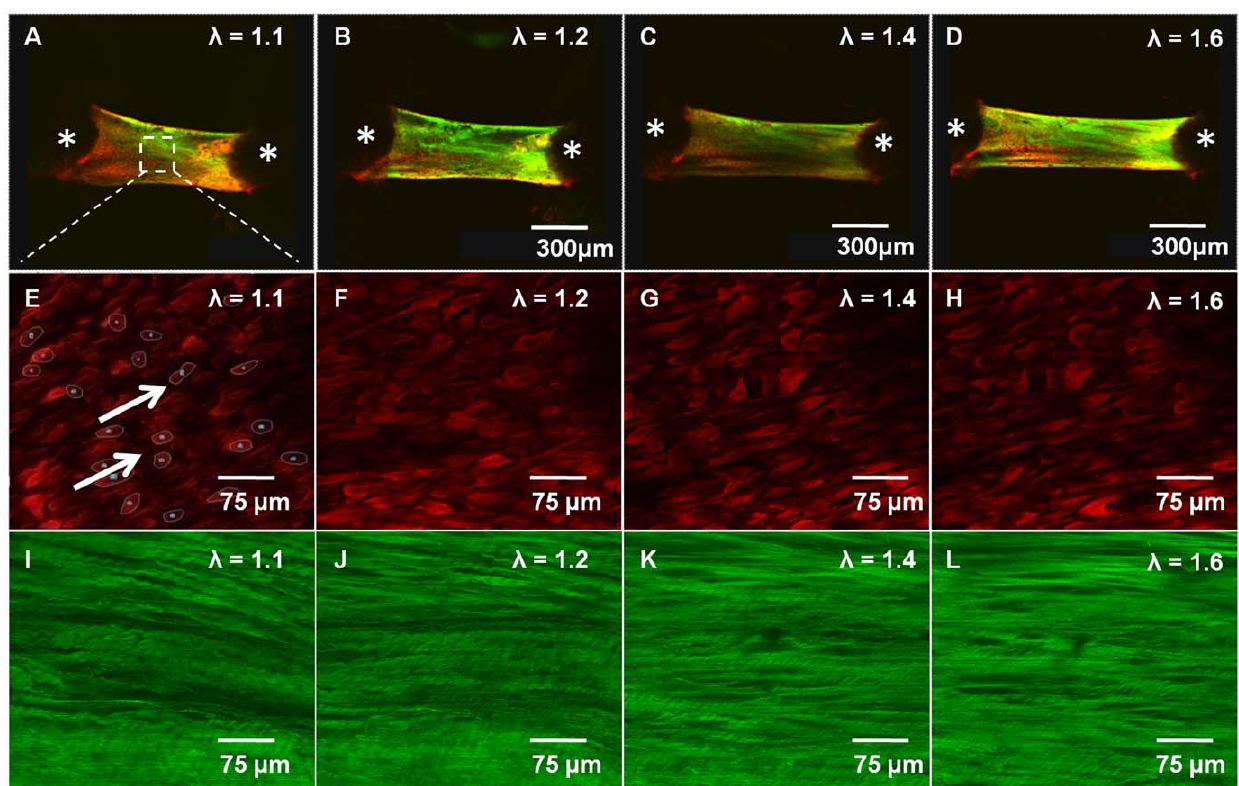
Figure 2. Macro and micro-scale tissue analysis. (A–D) Macro scale valve deformation at varying stretch ratios ( l ) viewed at 10 6 under confocal microscopy (Green: 5-DTAF stained matrix fibers, Red: vital dye labeled cell bodies). Stars denote centroid location of the cantilever posts. (E–H) Micro-scale cellular deformation of the same group of cells viewed during the same test at 40X under confocal microscopy. Arrows denote tracked morphology of individual cells. (I–L) Micro-scale fiber alignment from the same region viewed during the same test at 40 6 under confocal microscopy. Fiber un-crimping and alignment is clearly visible as stretch progresses left to right.